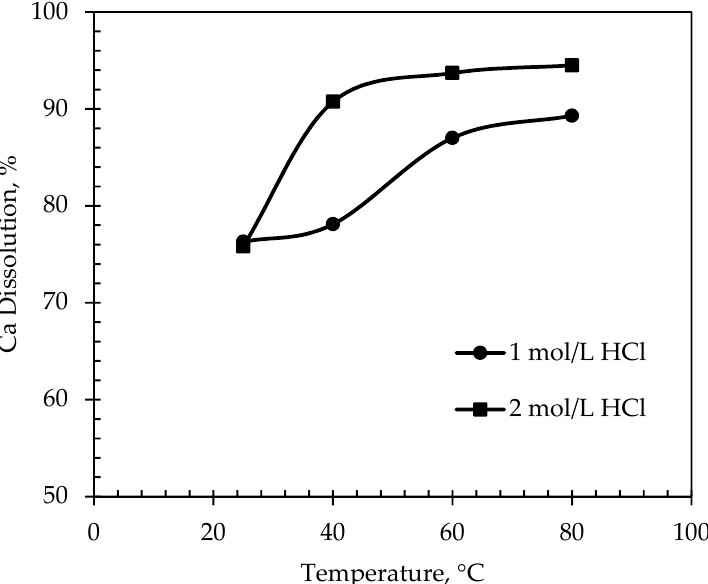
Figure 9. Calcium dissolution efficiency curve in different hydrochloric acid concentrations depending on temperature.